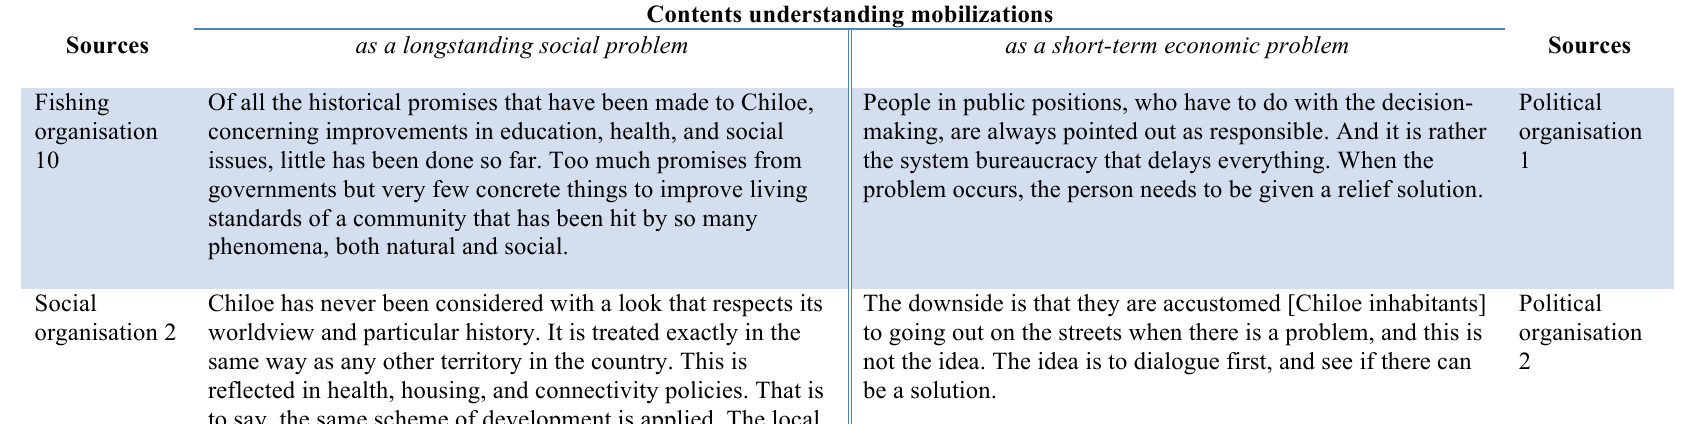
Table A2.3 Controversial sentences from in-depth interviews on the topic ‘mobilizations’ (including selected material from key